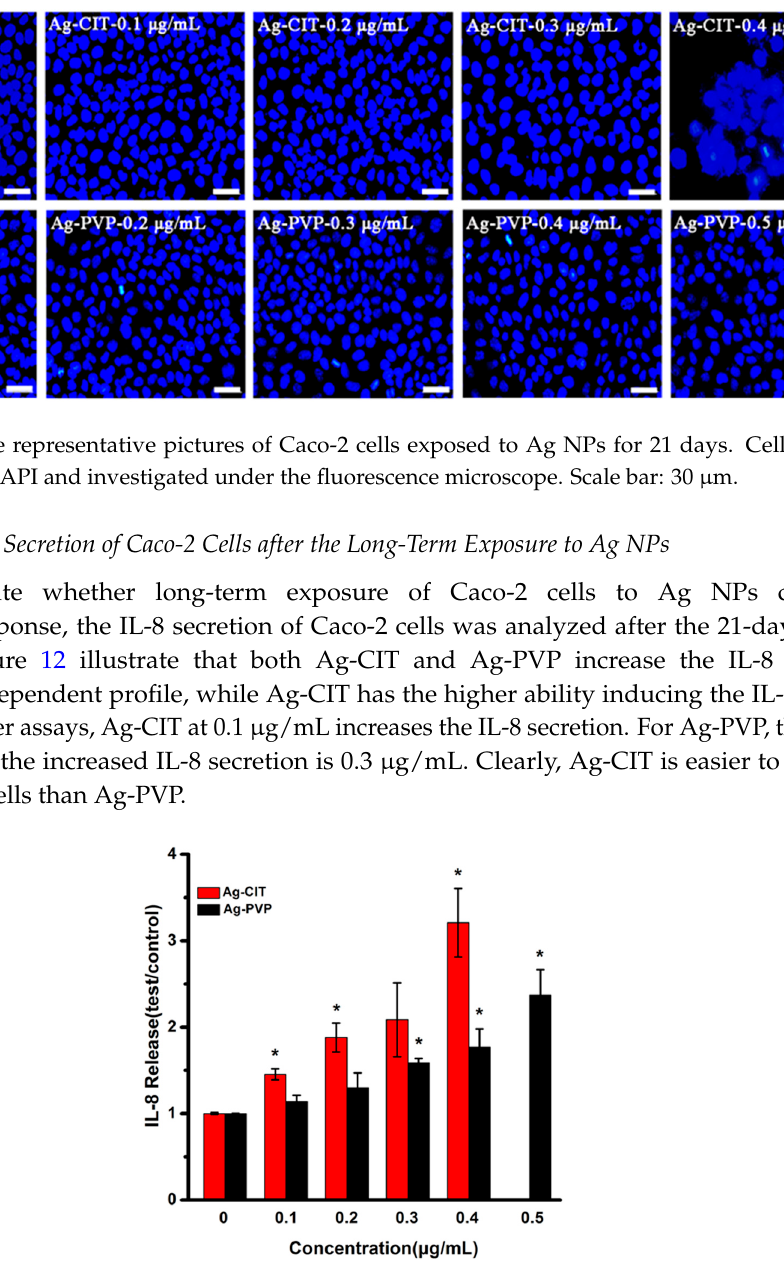
Figure 12. IL-8 secretion of Caco-2 cells after the long-term exposure to Ag-CIT and Ag-PVP for 21 days. All data are represented as the mean ± SD ( n = 6). * p < 0.05 comparing with the 0 μ g/mL control.